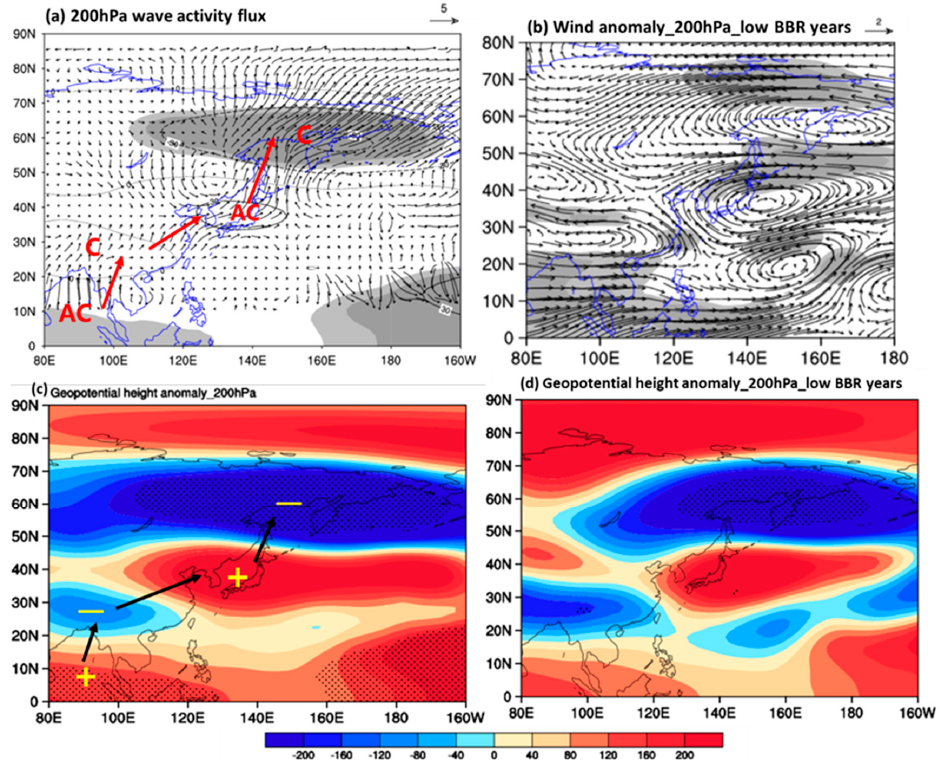
Figure 9. Composite maps of ( a ) wave activity flux at 200 hPa and ( c ) geopotential height anomalies at 200 hPa during spring in the EP El Niño years. Composite anomalies of ( b ) wind at 200 hPa and ( d ) geopotential height at 200 hPa during spring in the low-value BBR years. Shading areas in ( a ) and ( b ), and dotted regions in ( c ) and ( d ) have the anomalies being statistically significant at the 0.1 level (i.e., p < 0.1) estimated by a local Student’s t -test.